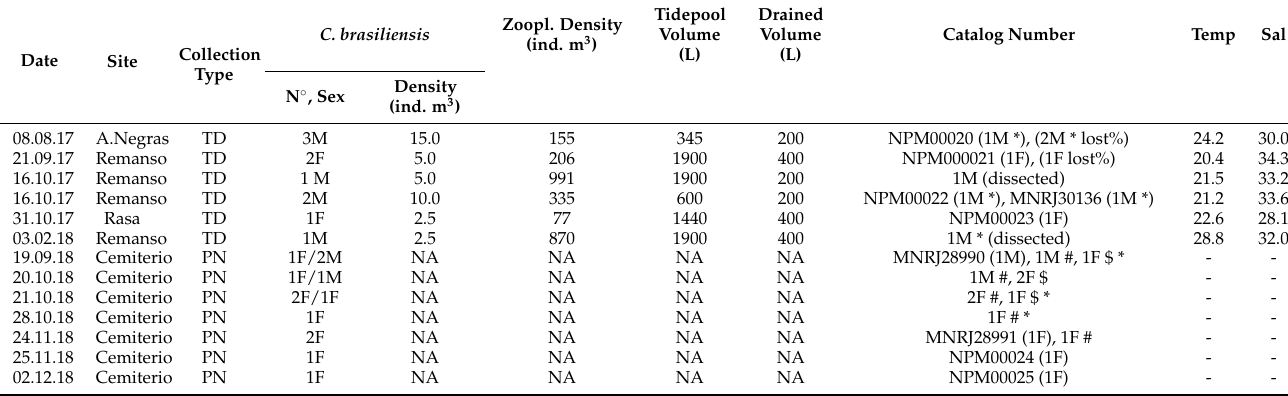
Table 1. Collection sites data. TD = Tidepool drainage, PN = Plankton net in shallow coastal area, M = male, F = female, temp = water surface temperature ( ◦ C), sal = surface water salinity. NA = no data available. Collections at Cemiterio beach were not made in tidepools, but in the coastal zone without using a flowmeter, thus without volume and density